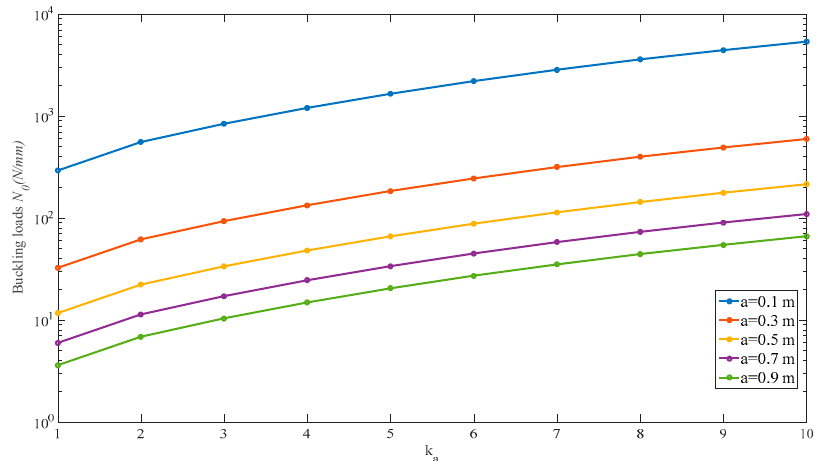
Table 2. Buckling loads vs. k a .